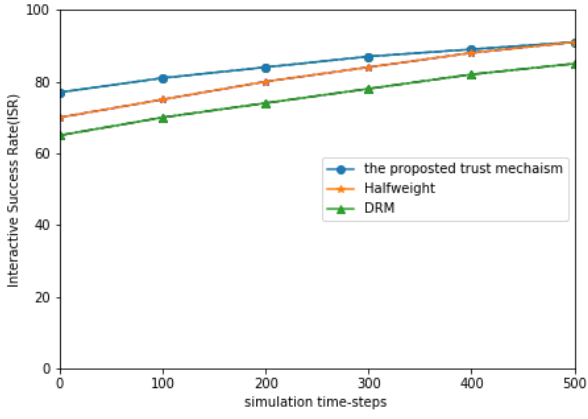
Figure 7. The proportion of MNs is 40% and that of PCN is